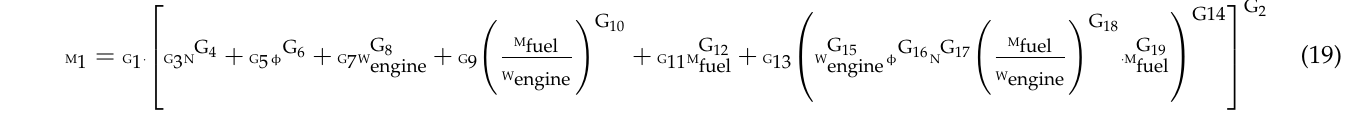
The G i terms and their resulting optimized values are shown in Table